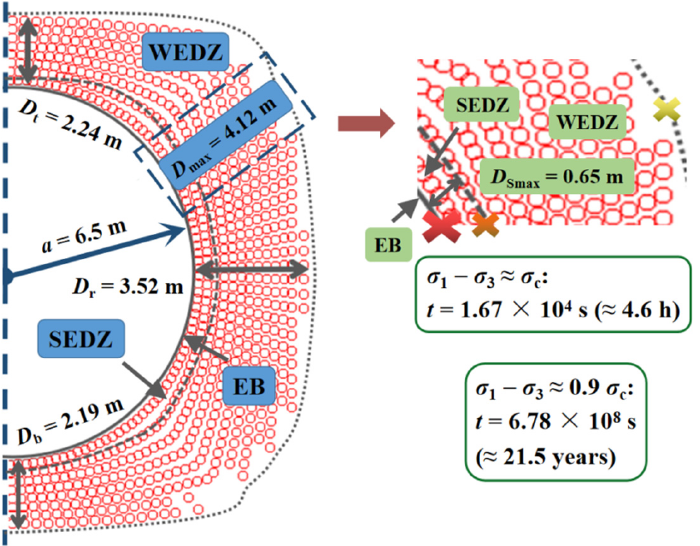
Figure 10. Time-delayed failure laws in EDZ for the round tunnel cross section at the depth of 1900 m ( a = 6.5